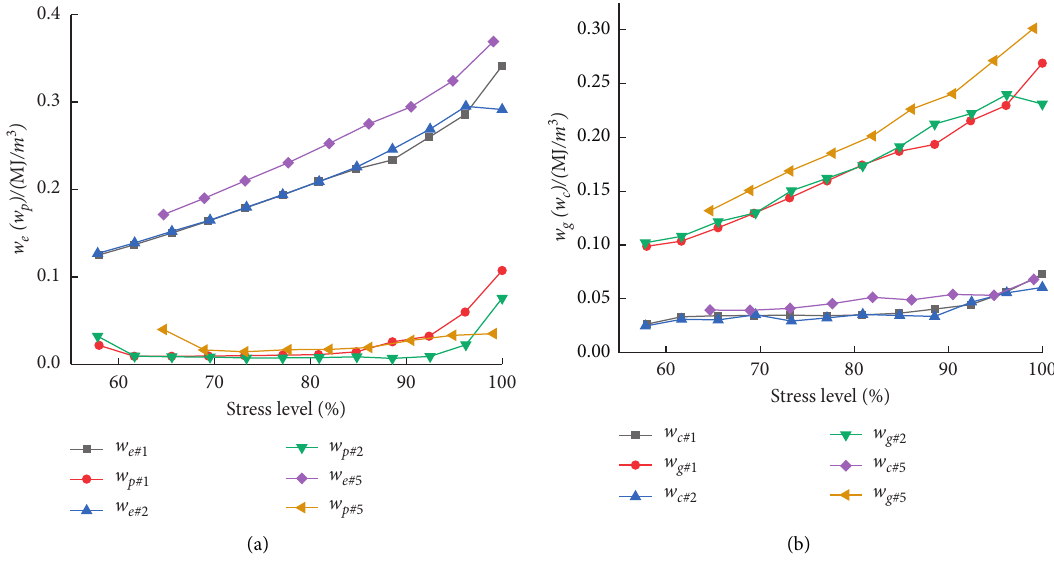
Figure 7: Energy-stress level